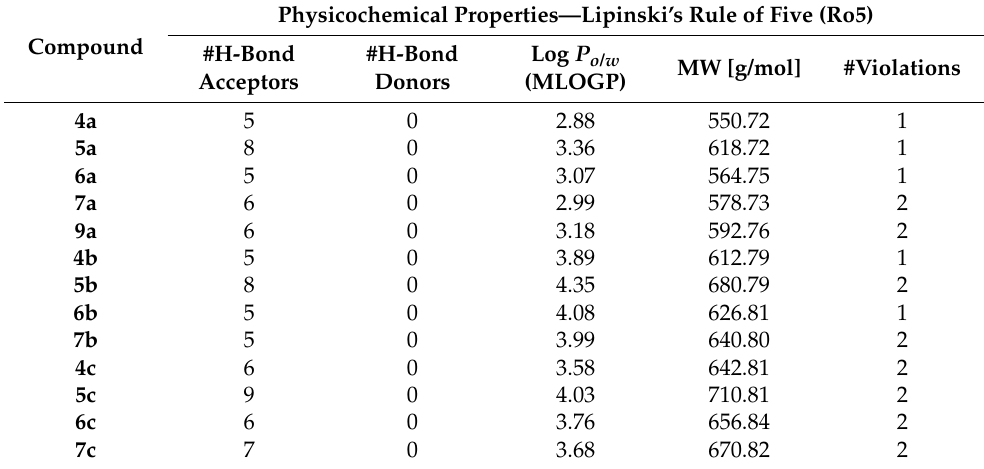
Table 9. Predicted physicochemical properties of studied compounds using SWISSADME server.